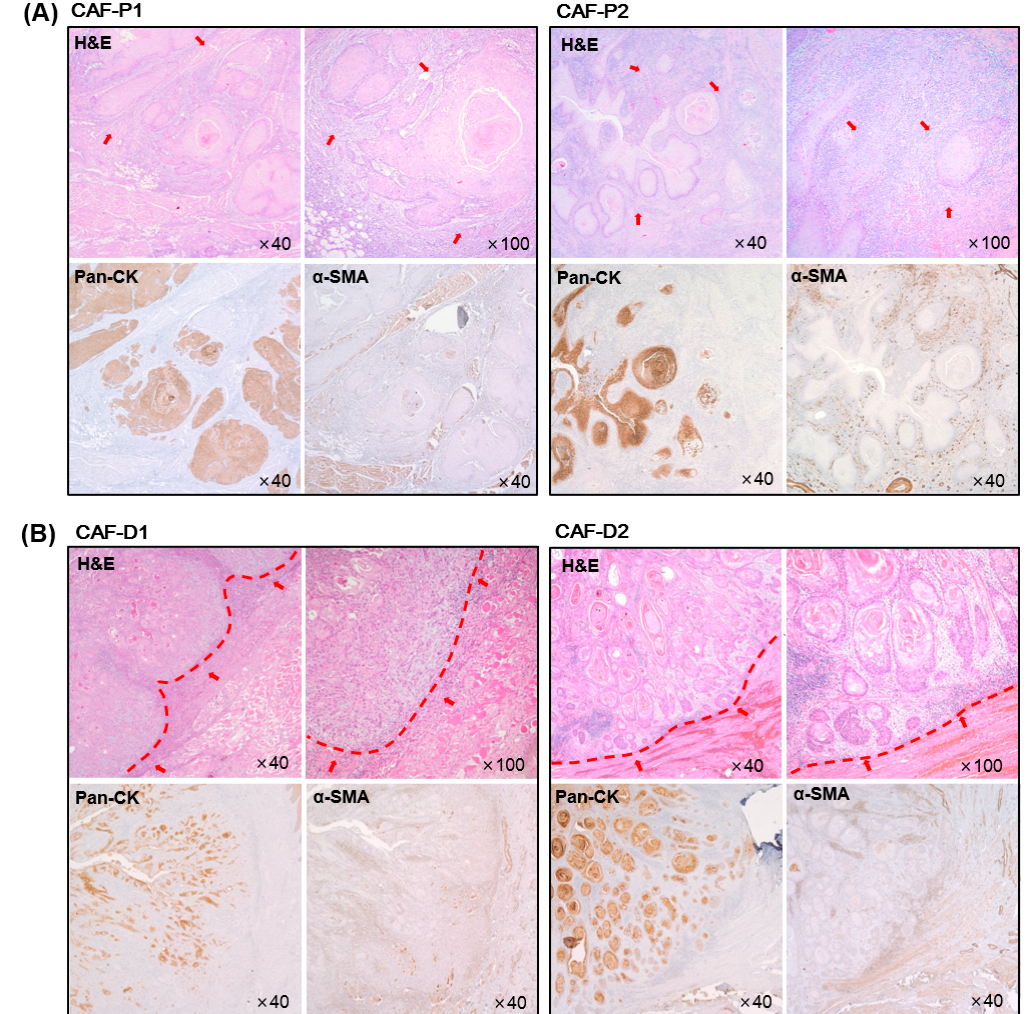
Figure 1. Immunohistochemical analysis of tumor tissues from HNSCC patients. Hematoxylin and eosin (H&E) staining was performed using HNSCC tumor tissues. Representative cancer stroma, including CAF, is shown with red arrows. Pan-cytokeratin (Pan-CK) and α -SMA staining was conducted at the same time to evaluate the epithelial cancer cells and CAFs, respectively. ( A ) Representative image for CAF-P. ( B ) Representative image for CAF-D. The boundary between epithelial cancer and adjacent stroma was marked with a red line.